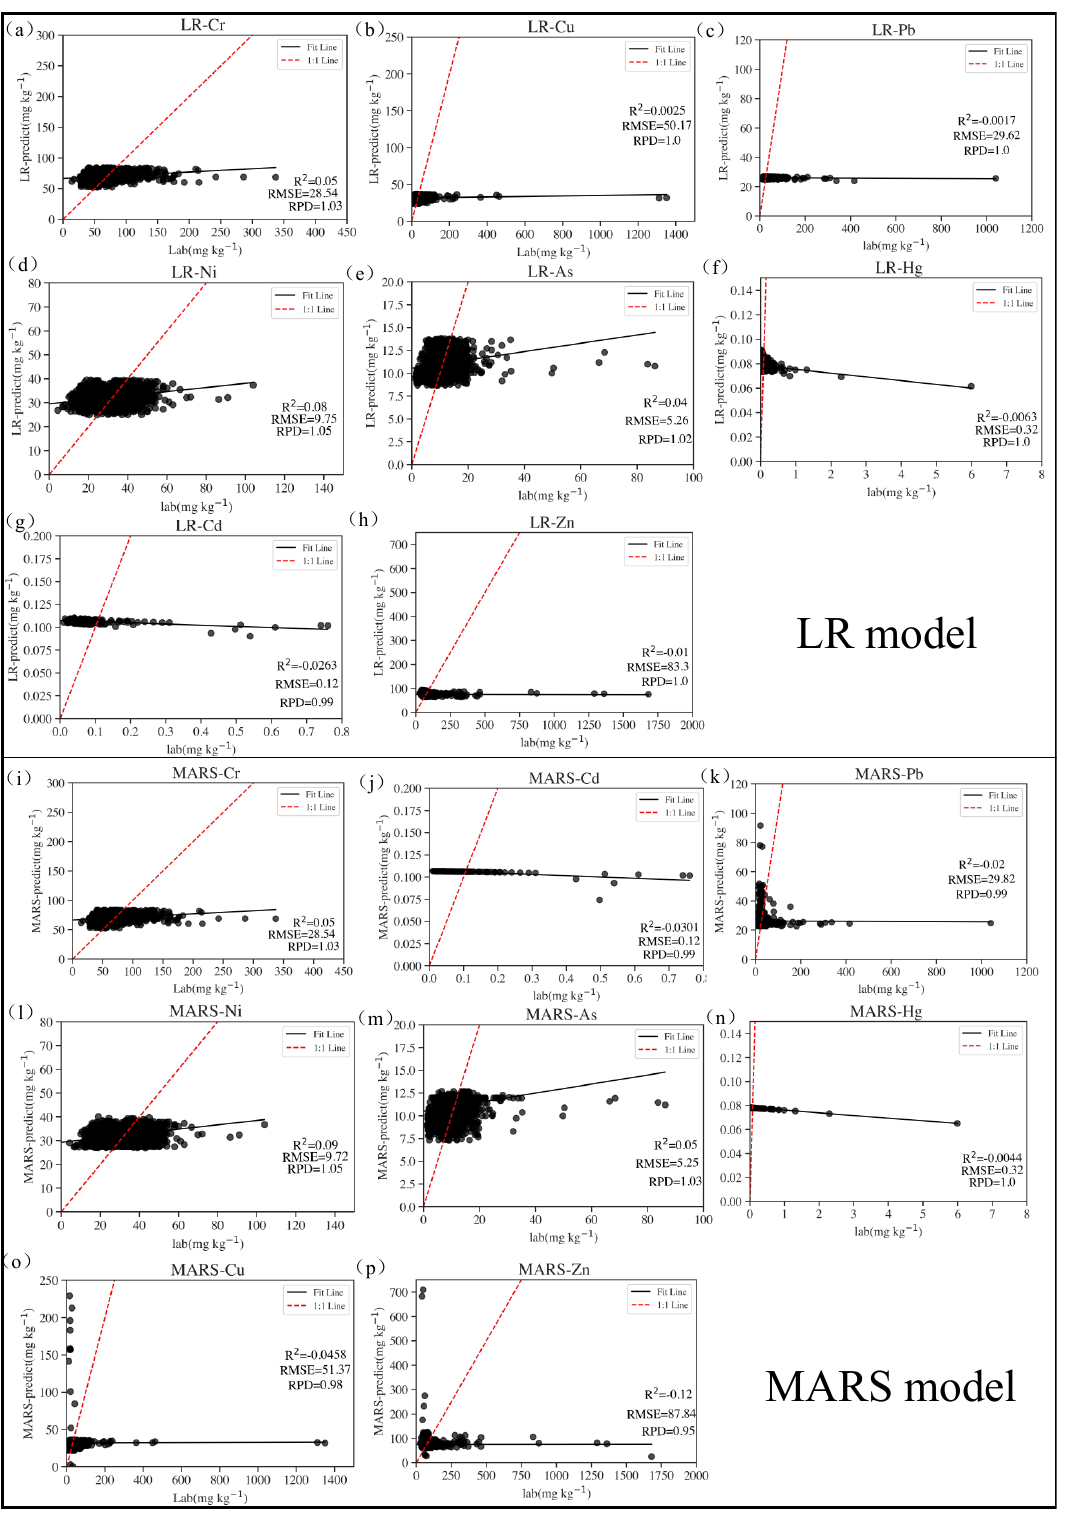
Figure 3. Concentrations of heavy metals predicted from each pXRF measurement using LR and MARS models against laboratory values of samples in the pXRF low-value dataset. The red dashed line is the 1:1 line, the black line is the regression line, and the points are semi-transparent to show point density. ( a – h ) Prediction results of LR models. ( i – p ) Prediction results of MARS model. The results of the pXRF low-value dataset showed that the R 2 and RPD values of the LR and MARS models were smaller than 0.1 and 1.4, which indicated that the models